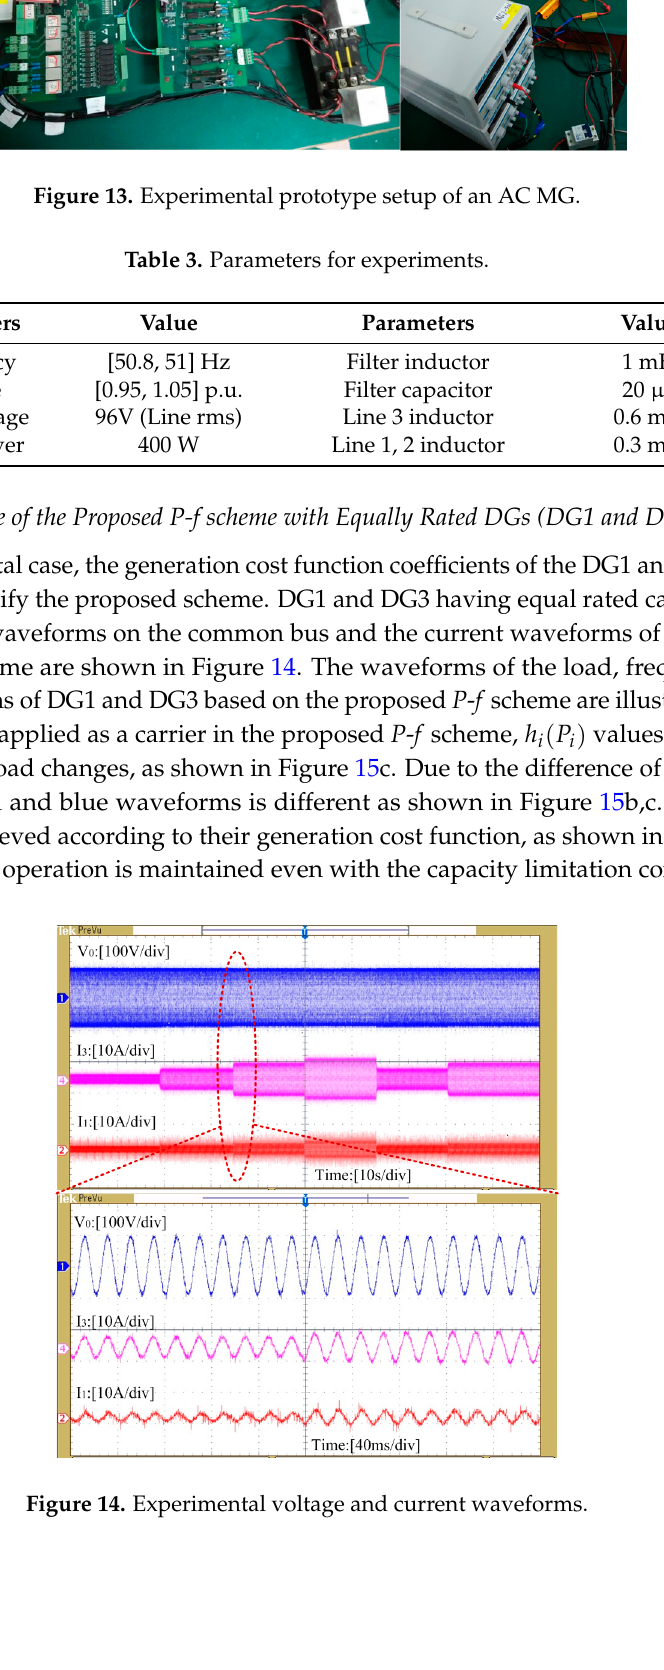
Table 3. Parameters for experiments.